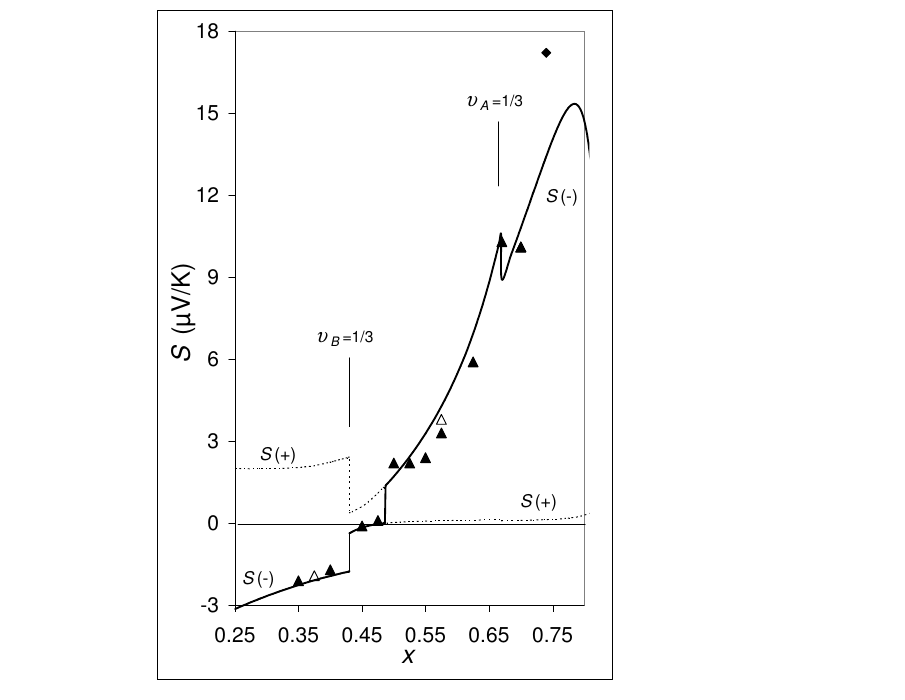
Figure 5. Same as Figure 1, where however S B = 0 and κ e , B = 0 are set for υ B < 1/3 and S A = 0 and κ e , A = 0 are set for υ A < 1/3. For υ i < 1/3 the phase i exists as islands separated from each other. (The curve for S ( − ) agrees with that obtained by Sonntag